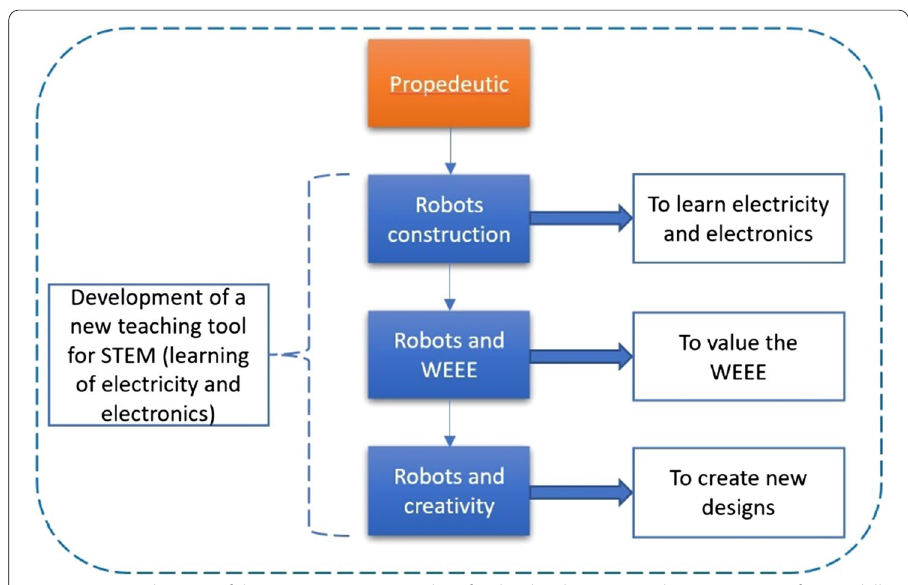
Fig. 9 Proposed stages of the BEAM course curriculum for the development and improvement of STEM skills and